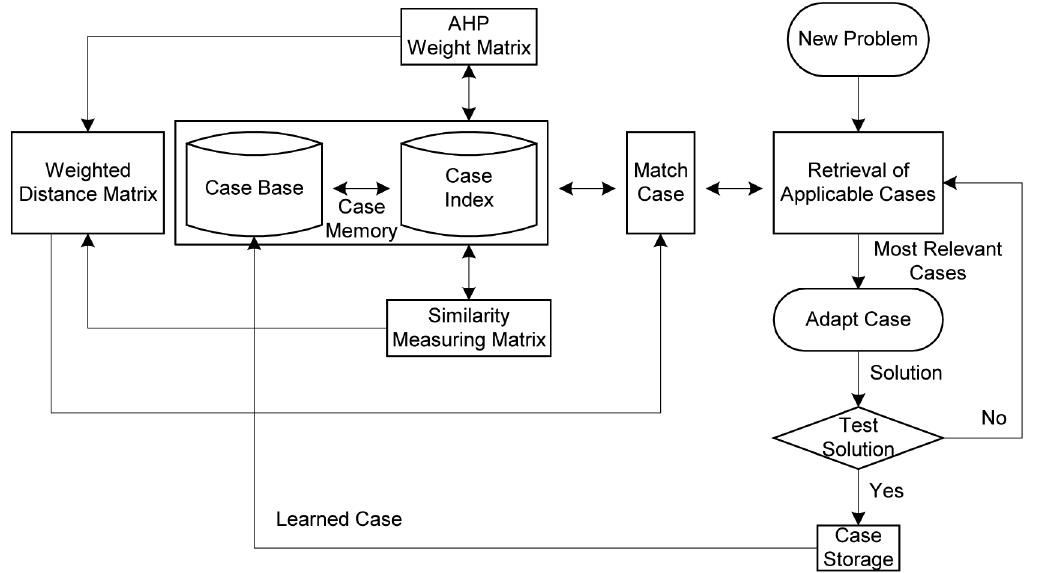
Fig. 4. Hybrid AHP-CBR